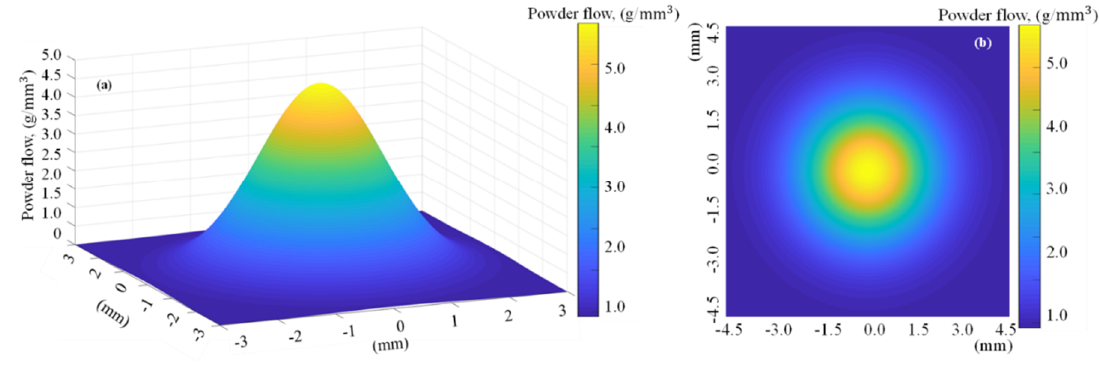
Figure 4. A three-jet powder stream distribution ( a ) experimental image and ( b ) image processed via “Image J” software; all units are in millimeter (mm).